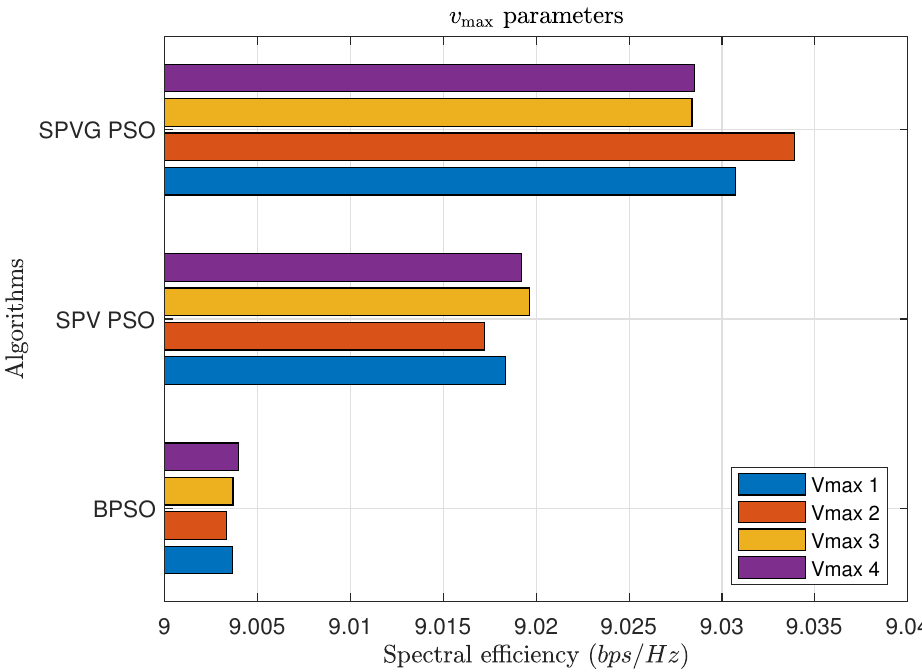
Figure 5. Result of tests to find the better parameter to v max ( K = 20, R = 1000 m and ( ω ) = 0.25). The third and forth parameters tested were the local and global solution weights ( c 1 and c 2 ). These parameters are not found in the SPVGs variants, so they were only tested for BPSO and